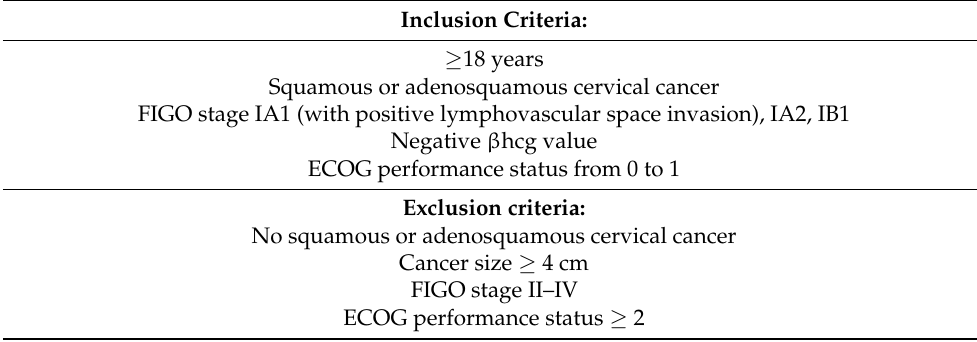
Table 1. Inclusion and exclusion criteria.